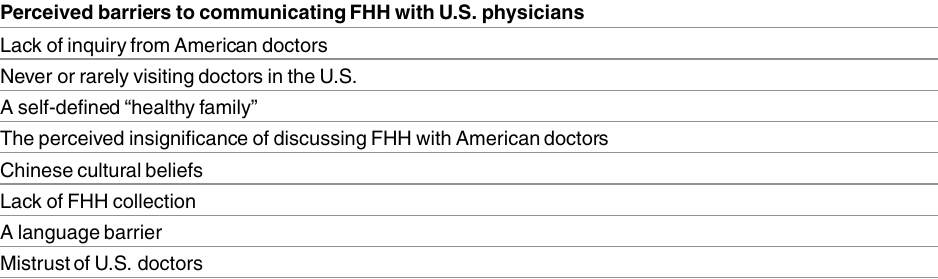
Table 3. Perceived Barriers to CommunicatingFHH withU.S. PhysiciansamongChinese American Participants. Perceived barriers to communicatingFHH with U.S. physicians Lack of inquiryfrom American doctors Never or rarely visiting doctors in the